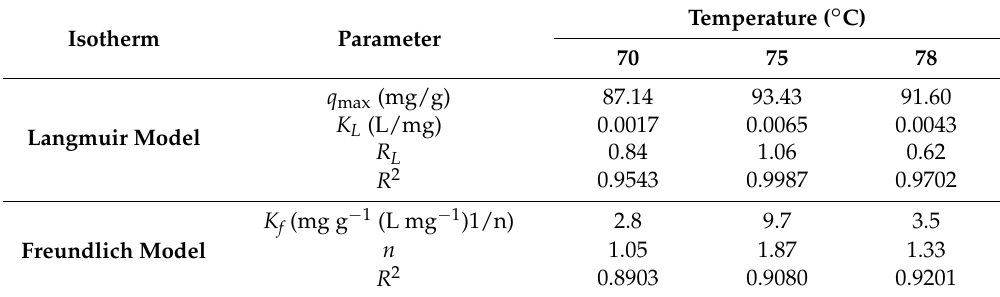
Table 3. Isotherm parameters for Co(II) adsorption onto LMT at different